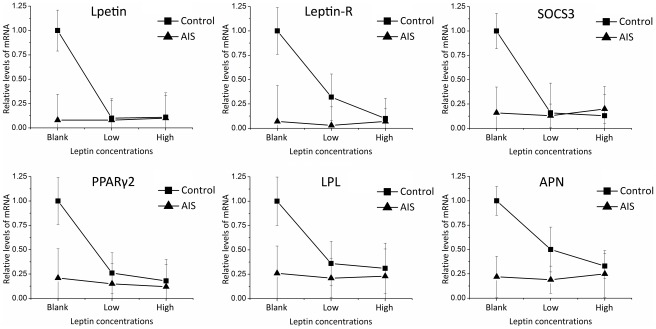
Gene expression levels in response to different doses of leptin.The expression levels in control group without leptin treatment were used as calibrators. Relative expression levels were calculated by using the 2−ΔΔCt method.